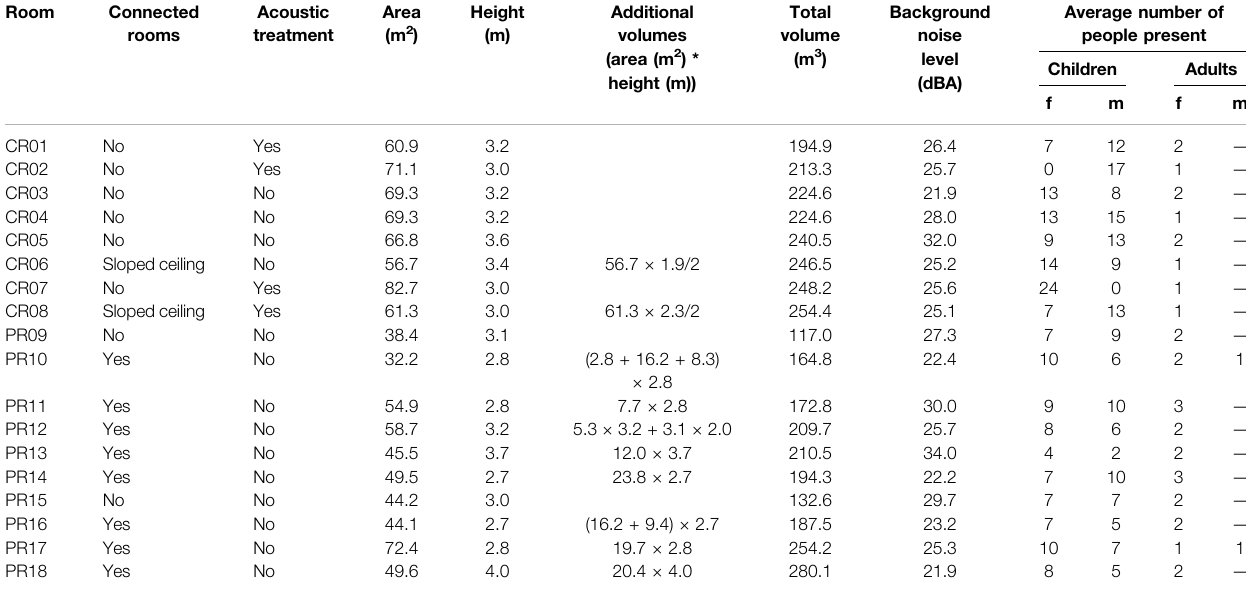
TABLE 2 | Overview of selected classrooms (CRs) and playrooms (PRs). Background noise measurements conducted in unoccupied rooms.